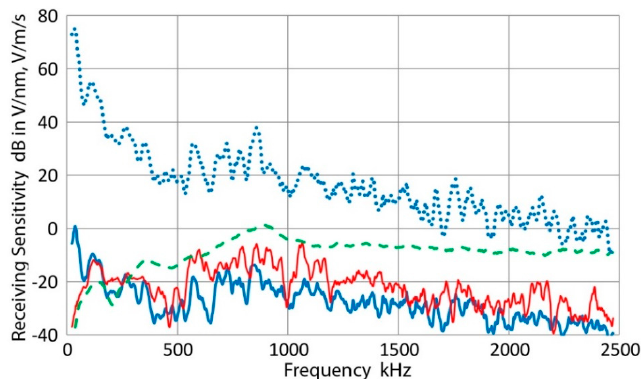
Figure 13. Receiving sensitivity of PAC S9220. The displacement receiving sensitivities to bar waves are shown in solid blue curve for the present work and in red curve from the old data [8] (reproduced with permission from [8]. Copyright AE Group, 2010). Green curve is the displacement receiving sensitivity to normally incident waves [4]. The velocity sensitivity corresponding to the solid blue curve is given in dotted blue curve.